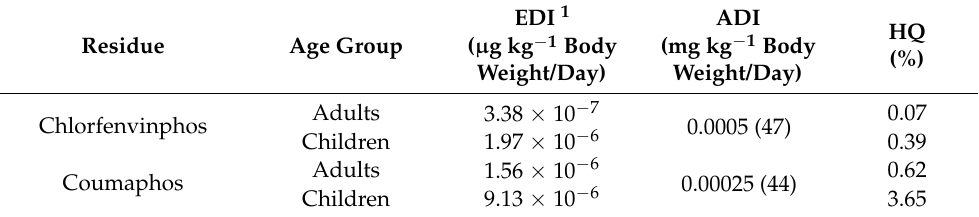
Table 2. Risk assessment of chlorfenvinphos and coumaphos due to honey